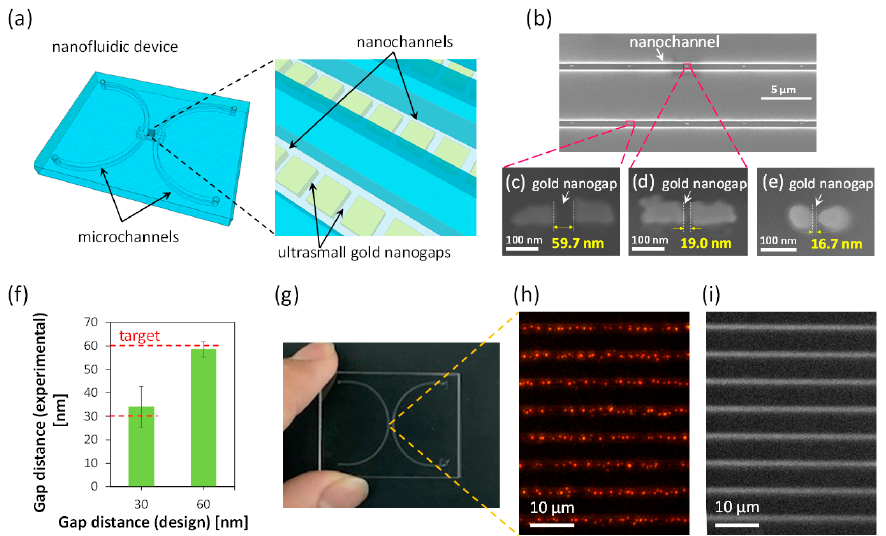
Figure 6. ( a ) Schematic of a nanofluidic device with ultrasmall gold nanogaps in nanochannels. ( b )SEM image of nanochannels with ultrasmall gold nanogaps. ( c – e ) SEM images of representative gold nanogaps. ( f ) Relationship between target value and average of the experimental value of the gold nanogap distance (n = 11 for each). ( g ) Photo of fabricated nanofluidic device. ( h ) Bright-field microscopic image of bonded nanochannels with ultrasmall gold nanogaps. ( i ) Fluorescent micro- scopic image of nanochannels with ultrasmall gold nanogaps after the introduction of rhodamine B solution (9.8 μ M).